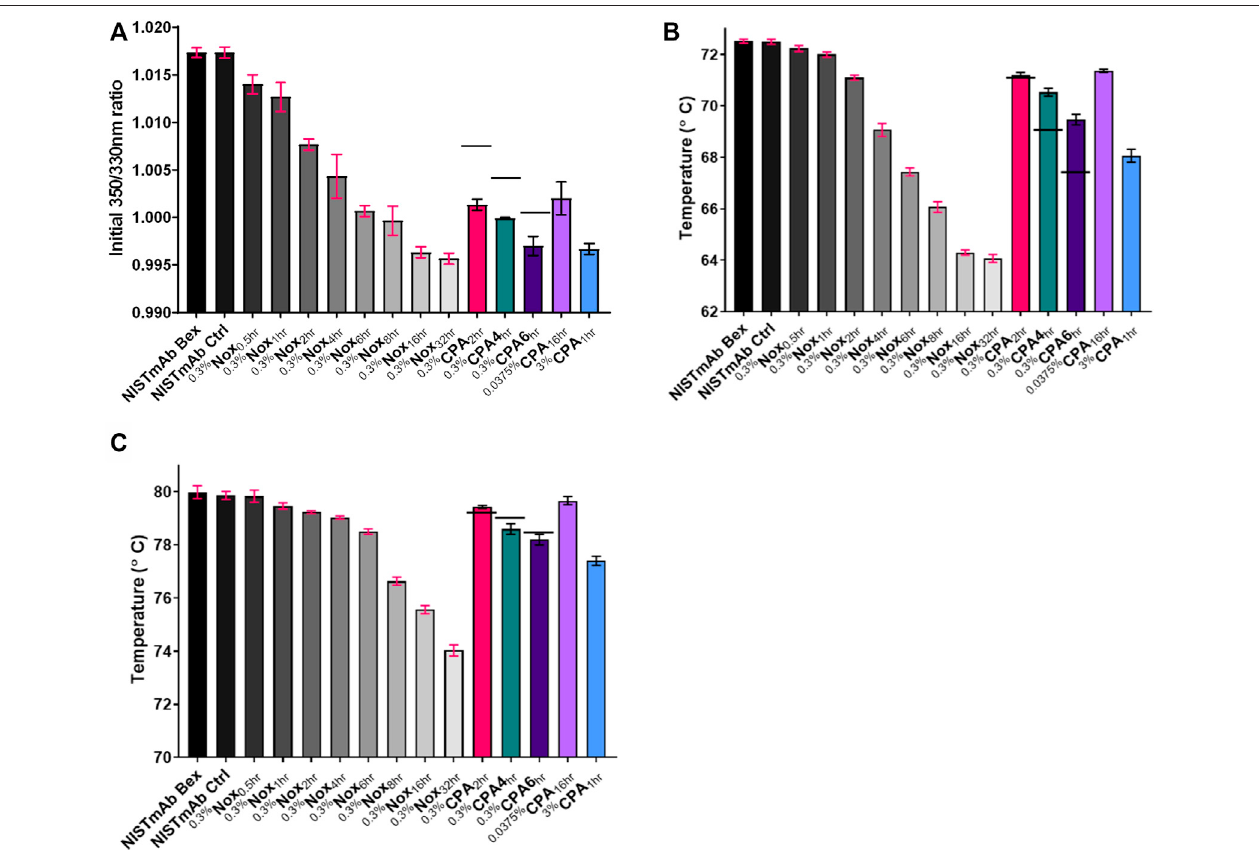
FIGURE9| Thermal unfolding analysisusing Tycho NT6.0 (A) Initial350 nm/330 nm ratio (B) In fl ection Temperature 1 (C) In fl ection Temperature 2. Thestandard deviation of each measurement is noted with error bars. Black dashes ( − ) are used in the 0.3% CPA samples to denote the relative binding af fi nity from equivlent timed Nox sample for comparison